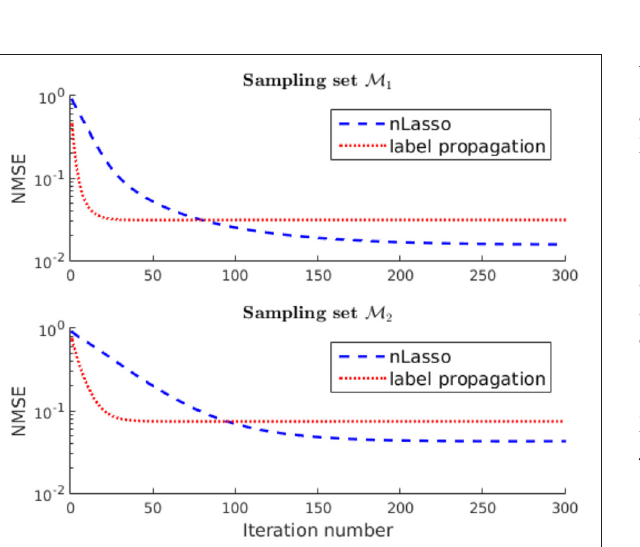
FIGURE 7 | Evolution of the NMSE achieved by increasing number of nLasso-ADMM iterations when using sampling set M 1 or M 2 , respectively.